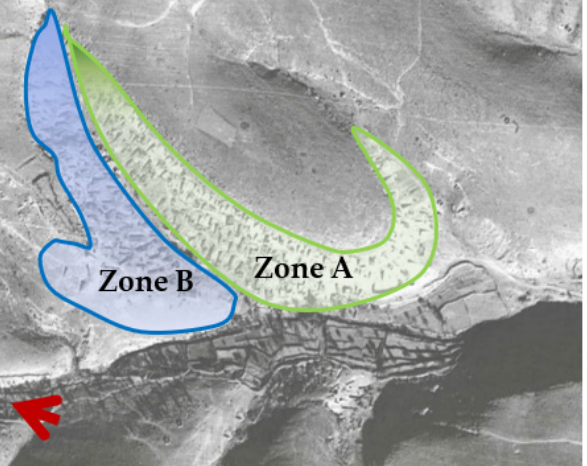
Figure 30. Zone A and Zone B located on the aerial image of Meymand village.